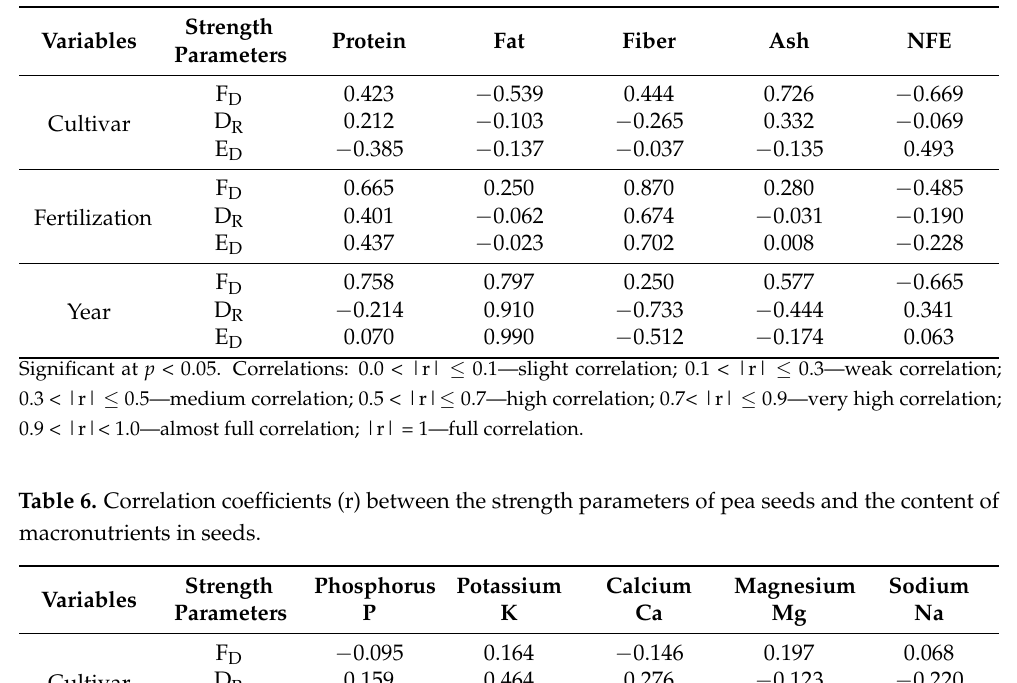
Table 5. Correlation coefficients (r) between the strength parameters of pea seeds and the content of organic components and ash in the seeds. Strength Protein Fat Fiber Ash NFE Variables Parameters F D 0.423 − 0.539 0.444 − 0.669 D R 0.212 − 0.103 Cultivar